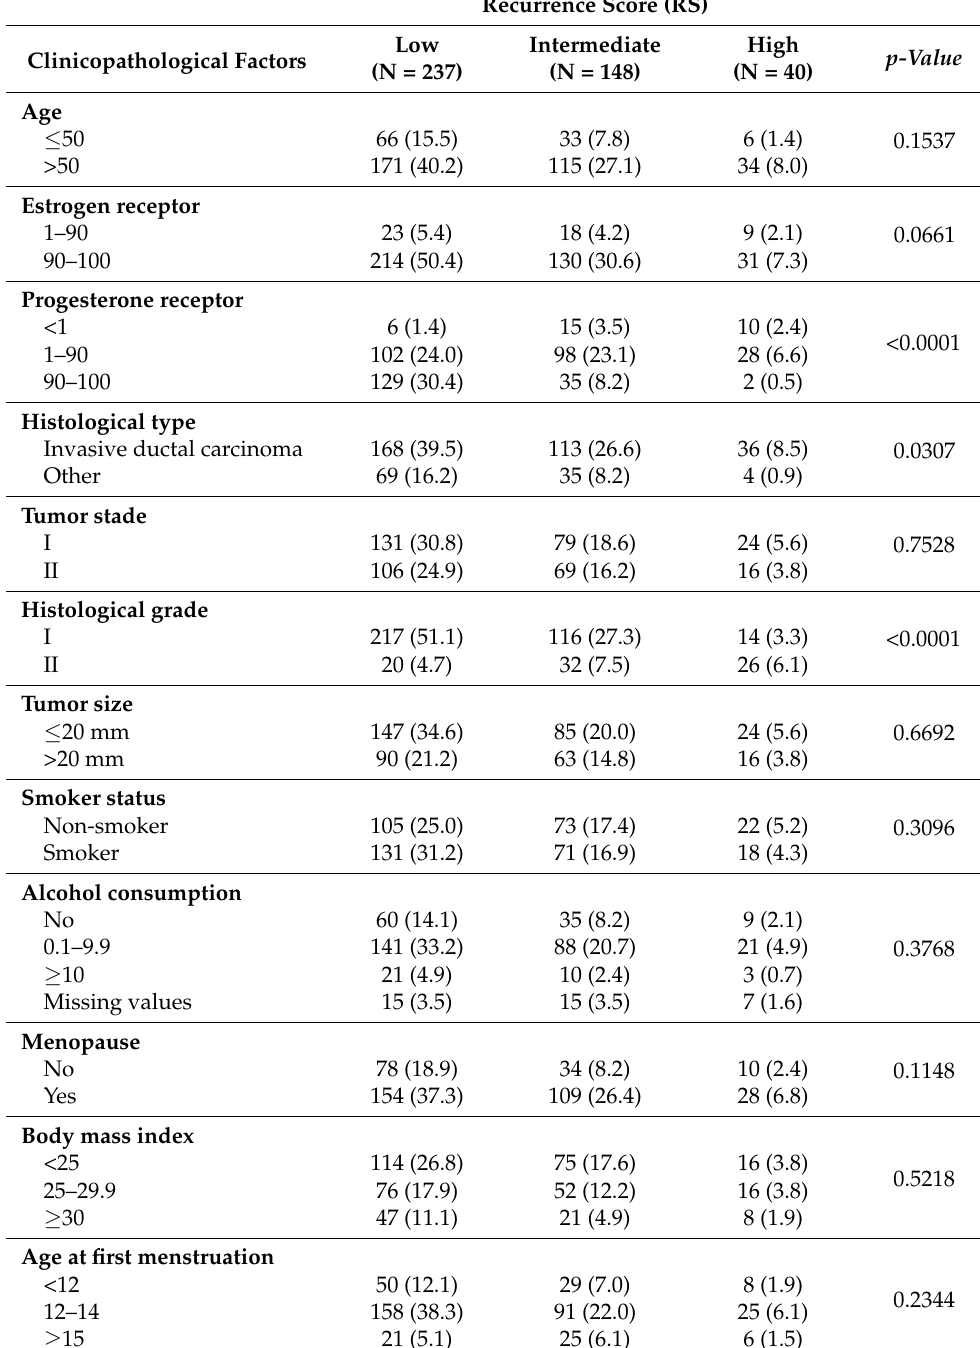
Table 2. Associations between clinicopathological factors and recurrence score category.